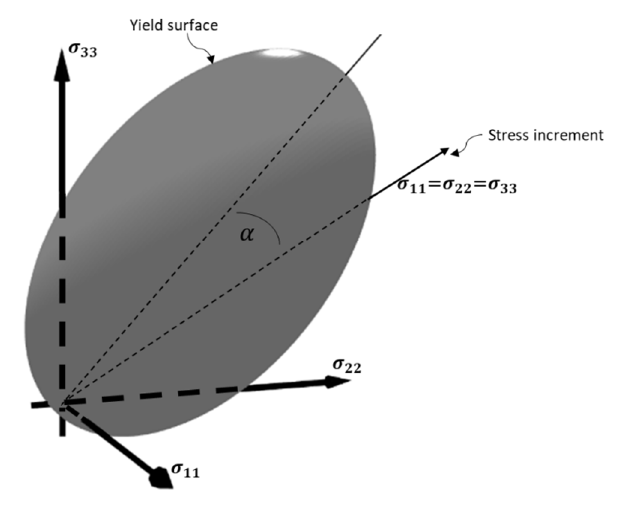
Figure 14. Yield surface and stress increment ( 𝜎 (cid:2869)(cid:2869) , 𝜎 (cid:2870)(cid:2870) and 𝜎 (cid:2871)(cid:2871) are the components of the stress in three principal tensor in three principal directions).